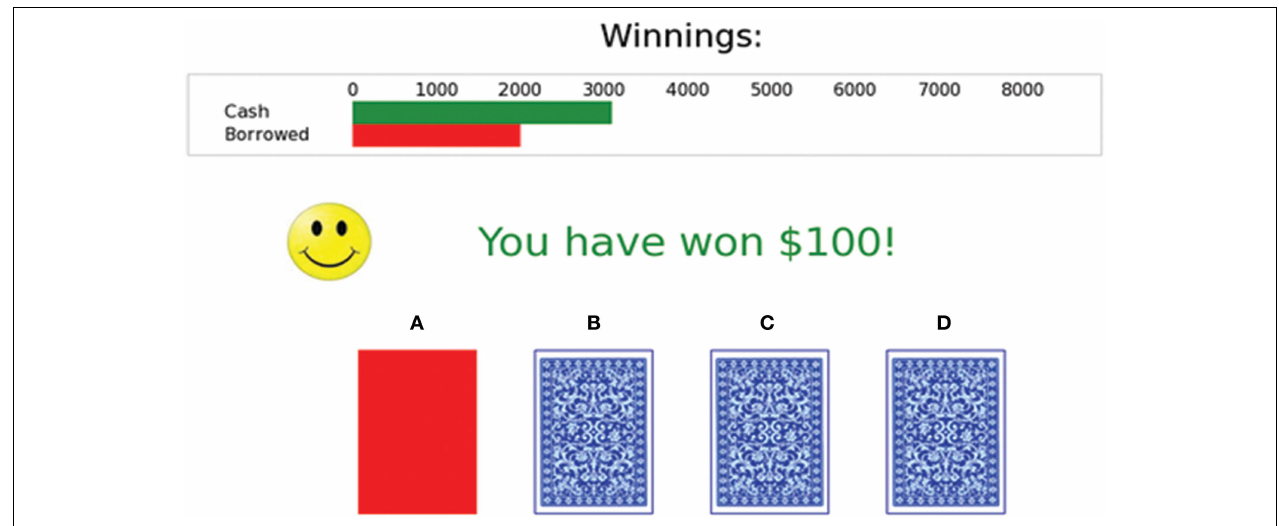
FIGURE 2 | Screen shot of the Iowa Gambling Task (modified PEBL implementation). The participant has just clicked on Deck A and received a $100